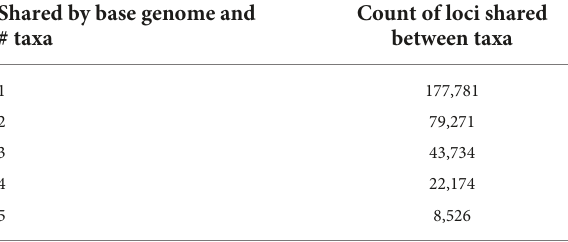
TABLE 2 Loci shared between base genome and other